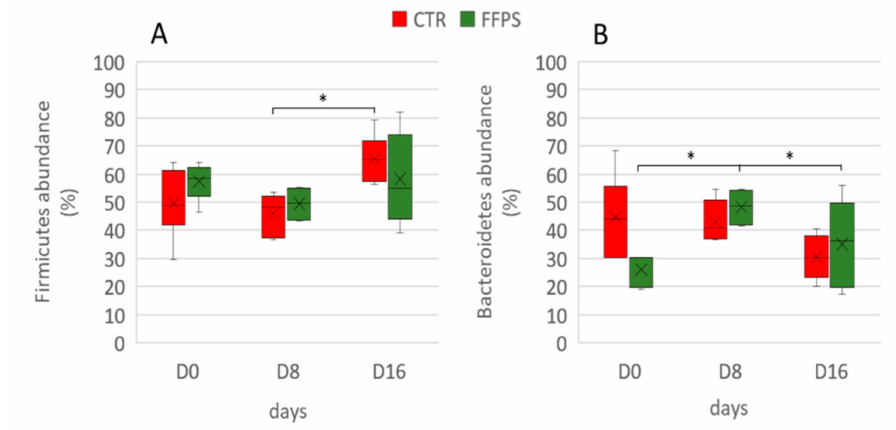
Figure 8. Temporal changes in Firmicutes and Bacteroidetes phyla in CTR (red boxes) and FFP (green boxes) groups. The proportions of Firmicutes ( A ) and Bacteroidetes ( B ) are shown for post-weaning piglets at days 0, day 8, and day 16 of the experiment. The lower boundary of the box is the 25th percentile, the line and the cross within the box mark the mean indicators, and the upper boundary of the box indicates the 75th percentile. Whiskers (error bars) above and below the box indicate the 90th and 10th percentiles; the symbol * indicates p -values <